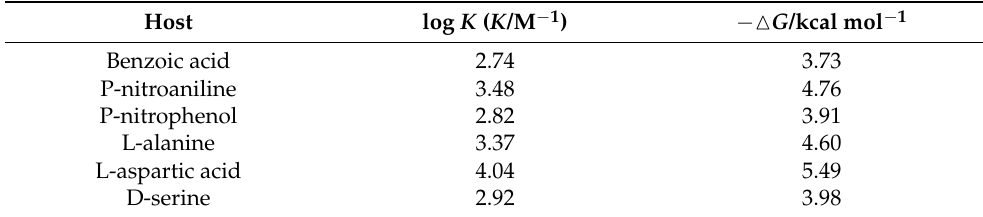
Table 1. Some examples of binding constants for the inclusion complexes formed between aromatic molecules and β -CD in the solution phase; all data taken from Liu et al. [26].